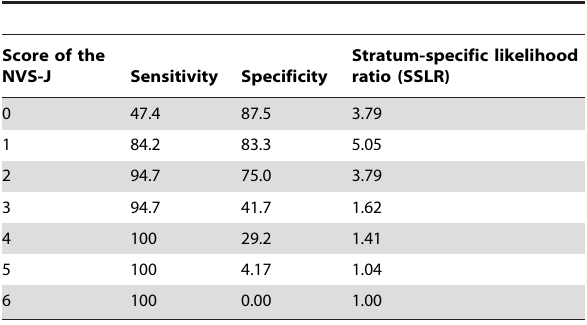
Table 6. Stratum-specific likelihood ratios for NVS-J cut-off scores by the CGI-HL.